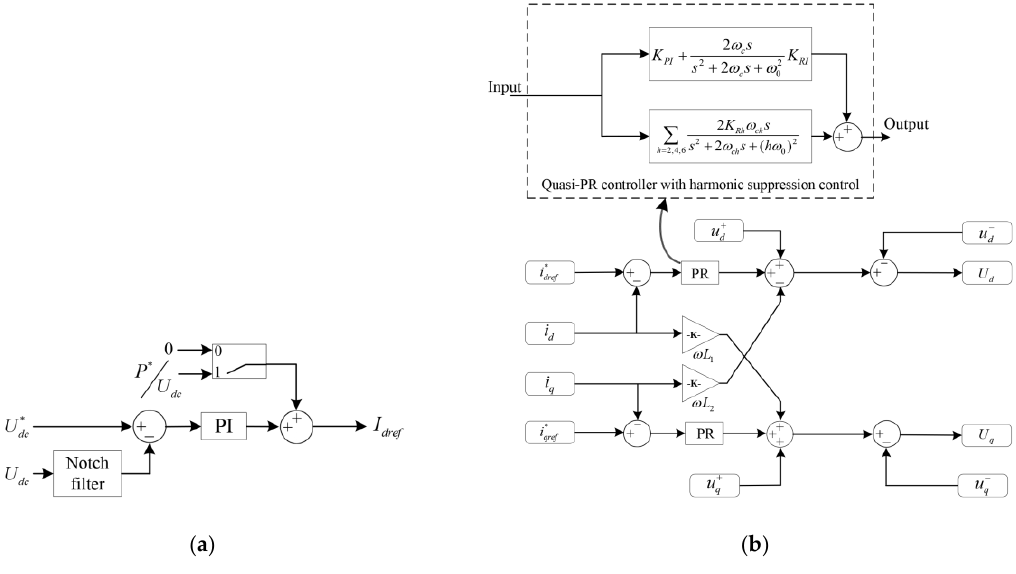
Figure 8. Control block diagrams of the inverter controller: ( a ) Outer-loop control block diagram; ( b ) Inner-loop control block diagram.